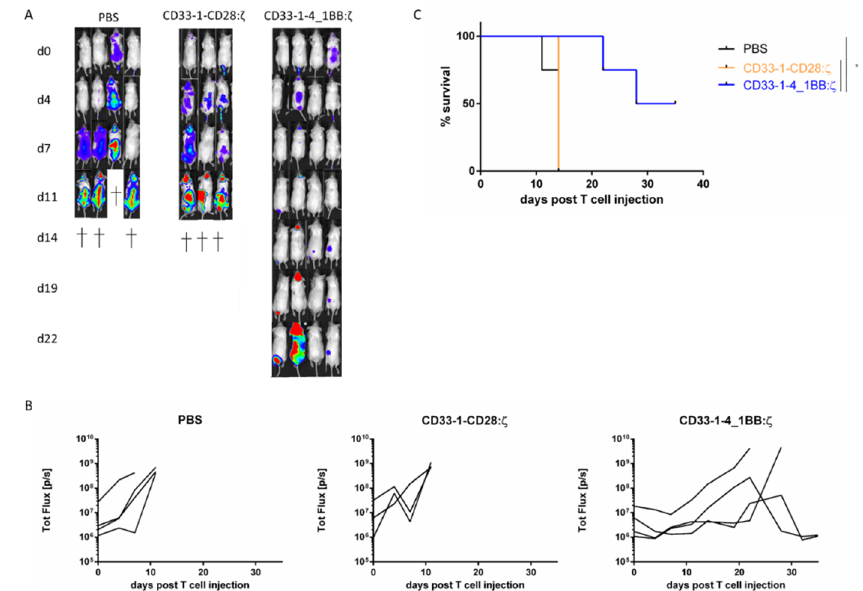
Figure 3. Eradication of CD33 + target cells in vivo and improvement of survival by CD33-1-4_1BB: ζ nanoCAR T cells but not by CD33-1-CD28: ζ nanoCAR T cells in a murine xenograft model: ( A ) Bioluminescence images showing tumor burden in NSG mice starting from day 0 post T cell injection; ( B ) Quantification of bioluminescence signal shown in a. Data points shown are the means, and error bars represent the SEM; ( C ) Survival of NSG mice treated with PBS, CD33-1-CD28: ζ or CD33-1-4_1BB: ζ nanoCAR T cells. Only significant results are indicated. * p < 0.05 by log-rank Mantel–Cox test.